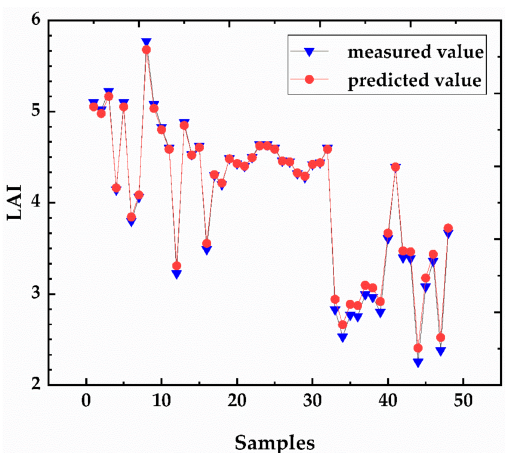
Figure 6. LAI-predicted results of the combined vegetation index neural network training (C-BPN) model.